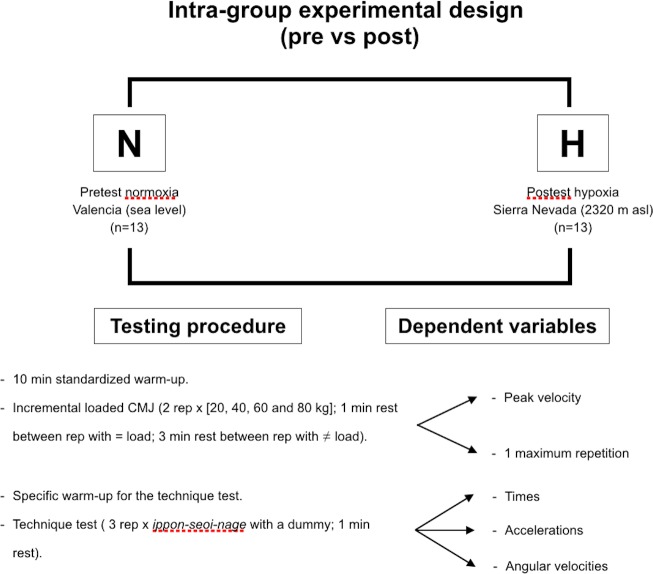
Experimental design.